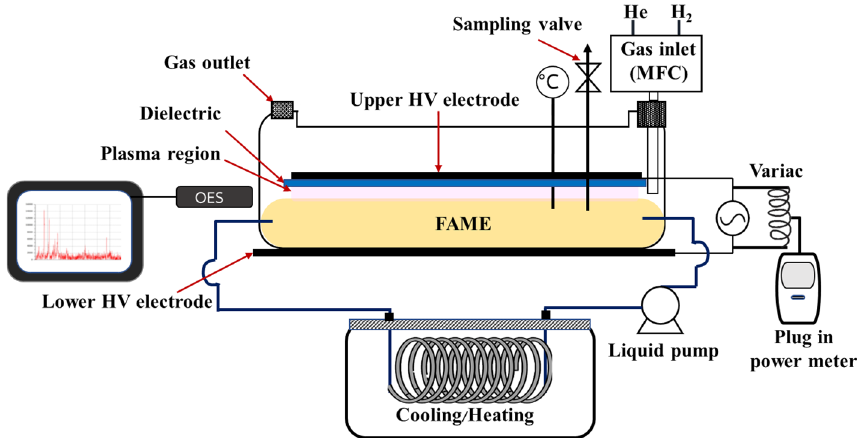
Figure 1. Drawing of constructed DBD plasma reactor (drawn using Microsoft PowerPoint version 2104, https:// www. micro soft. com/ th- th/ micro soft- 365/ power